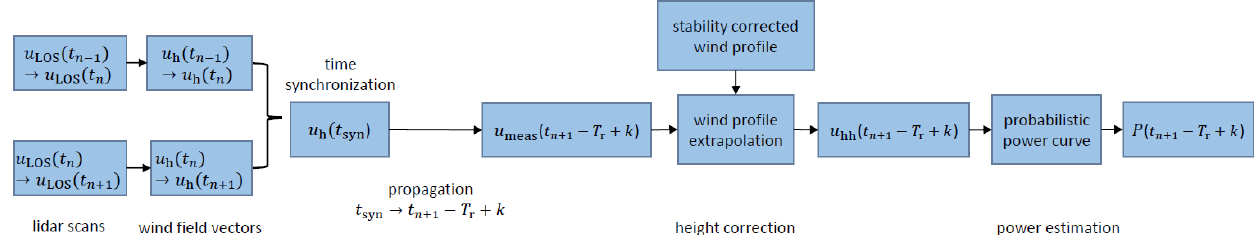
Figure 2. Schematics of the lidar-based forecast methodology. Line-of-sight wind speed measurements u LOS ,n measured within a time interval [ t n , t n + 1 − T r ] were filtered and a wind field reconstruction was performed. Using two consecutive lidar scans, the horizontal wind speeds u h ,n were then synchronized at time t syn . A propagation technique was applied to propagate wind vectors to t n + 1 − T r + k with end time of the scan t n + 1 , measurement reset time T r and lead time k . Wind speed forecasts u meas were further extrapolated to hub height and transferred to power forecasts by means of a probabilistic power